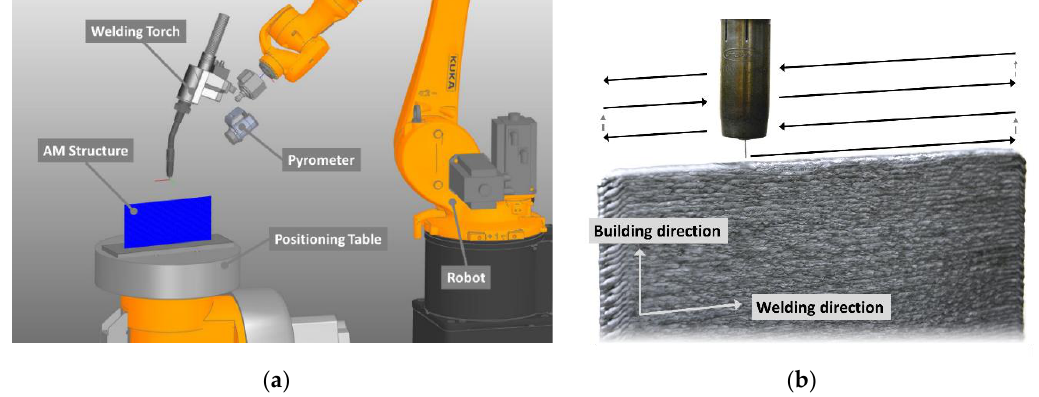
Figure 1. Experimental setup ( a ) and process sequence for sample preparation ( b ).